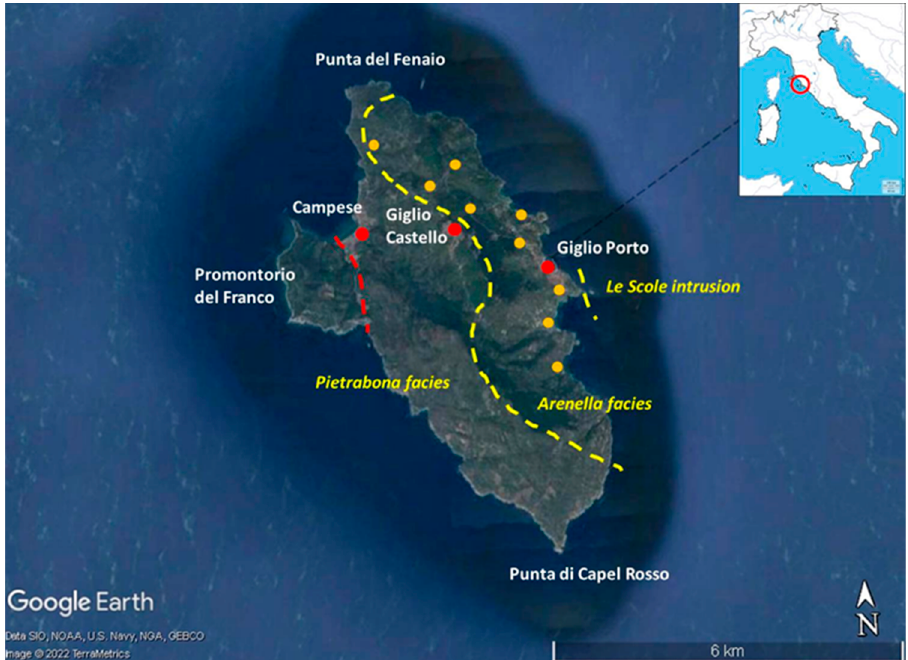
Figure 6. Detail of the nine sampling points along the roads of the island (yellow dots). The two yellow dashed lines separate, individually, the Pietrabona facies from the Arenella facies and the latter from the Scole Monzogranite Intrusion. The red dashed line separates the Franco promontory characterised by metamorthic and carbonate Mesozoic rocks (modified from Google Earth).